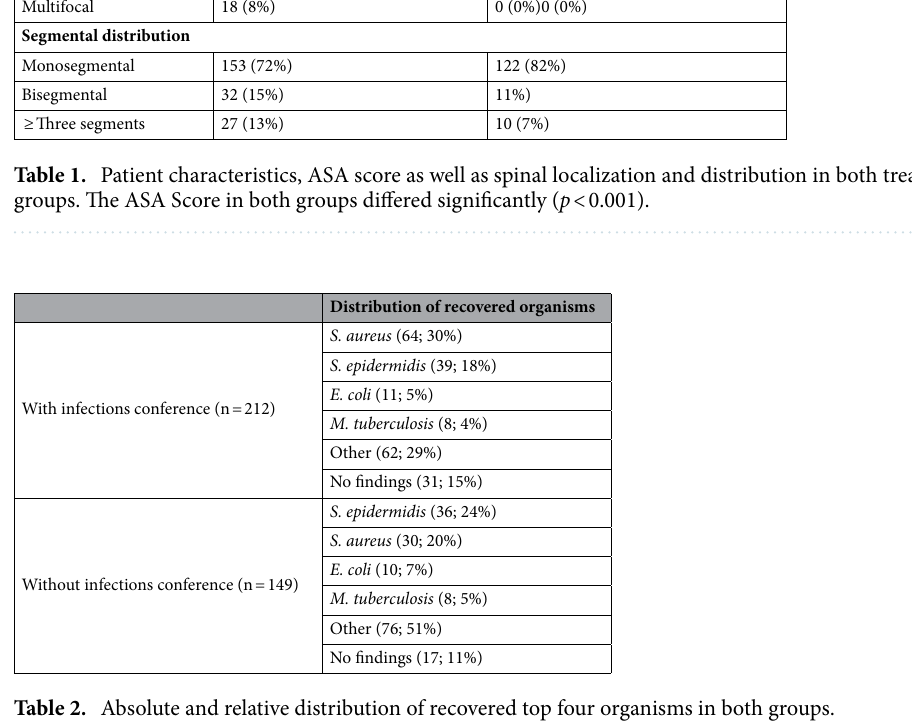
Table 2. Absolute and relative distribution of recovered top four organisms in both